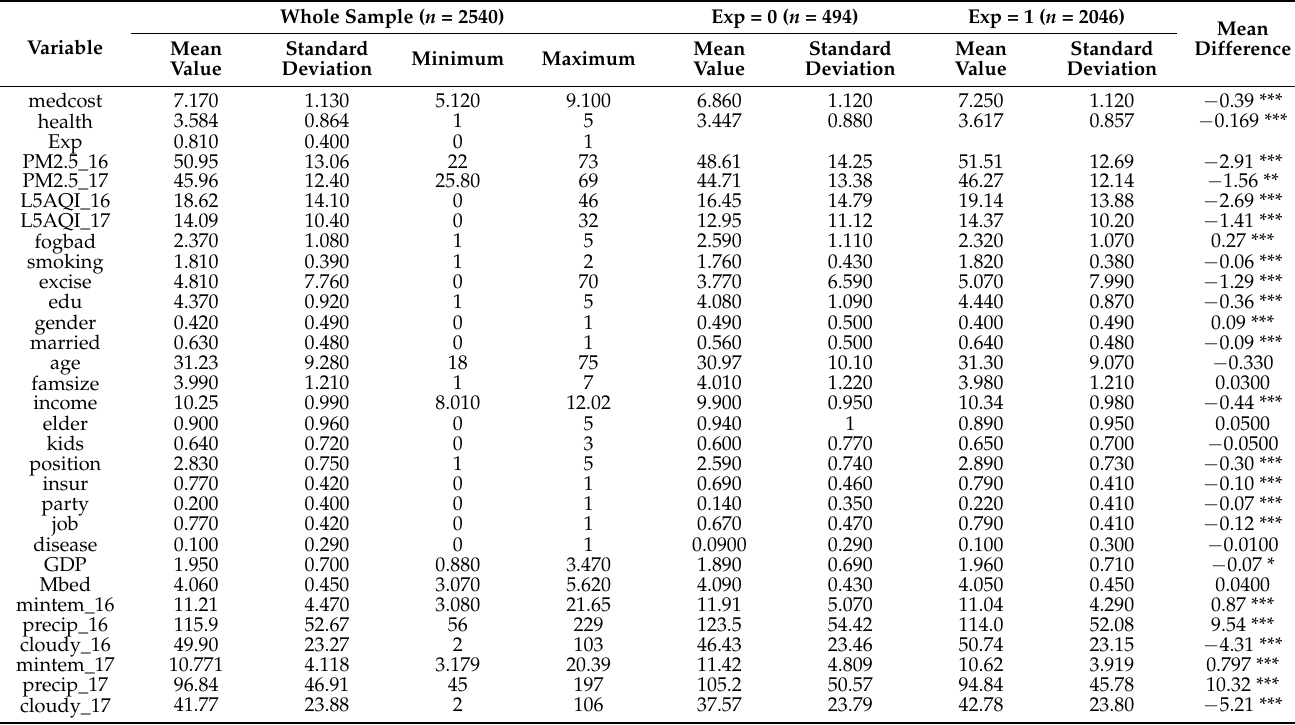
Table 3. Descriptive statistical analysis of